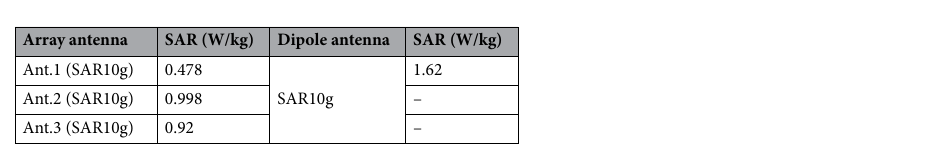
Table 4. The averaged SAR 10g for 20 dBm input power.